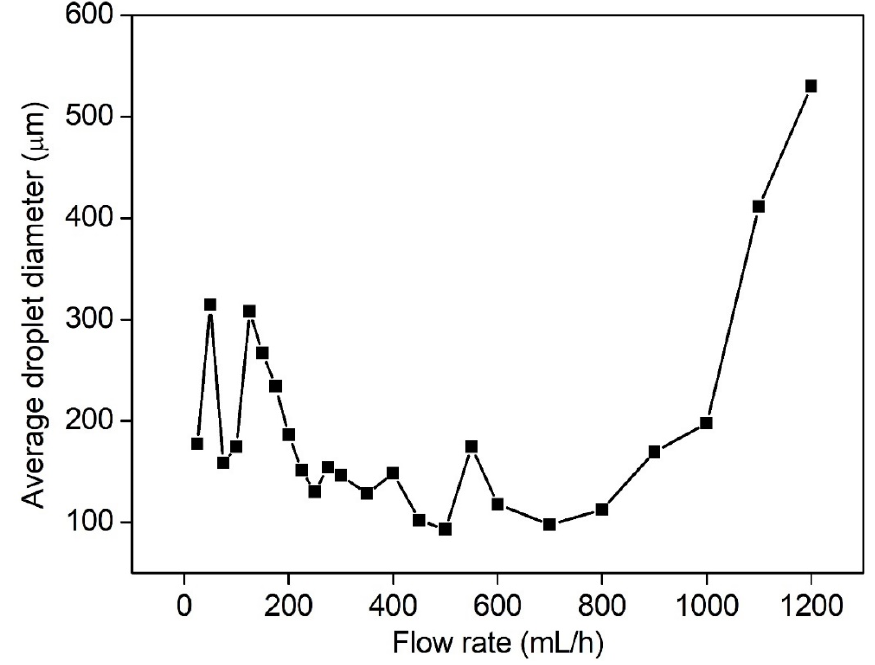
Figure 8. The average diameters of breakup droplets at different volume flow rates (21G nozzle, voltage of 28 kV, 35 wt. % concentration). voltage of 28 kV, 35 wt. %